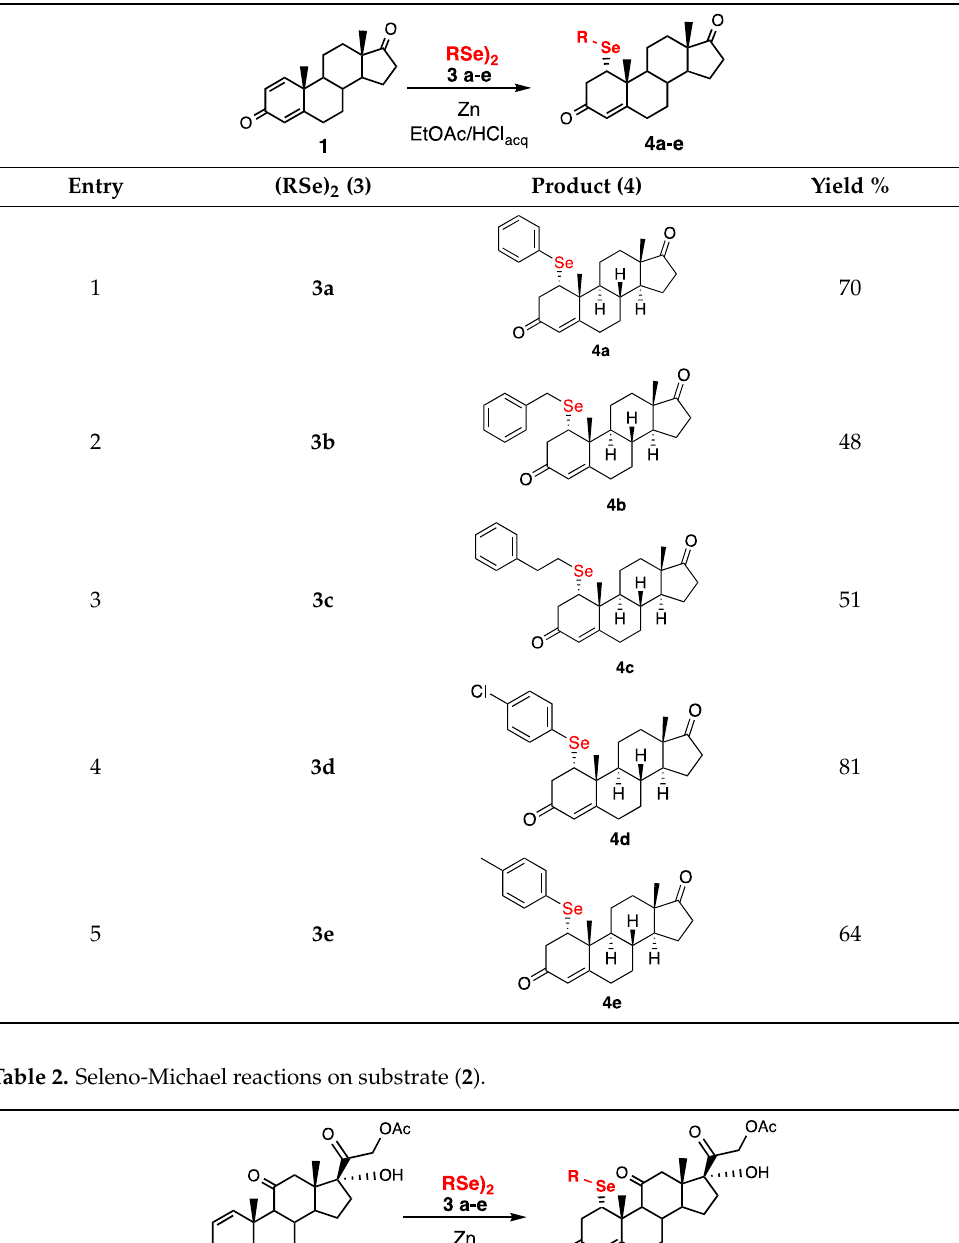
Table 1. Seleno-Michael reactions on substrate ( 1 ).